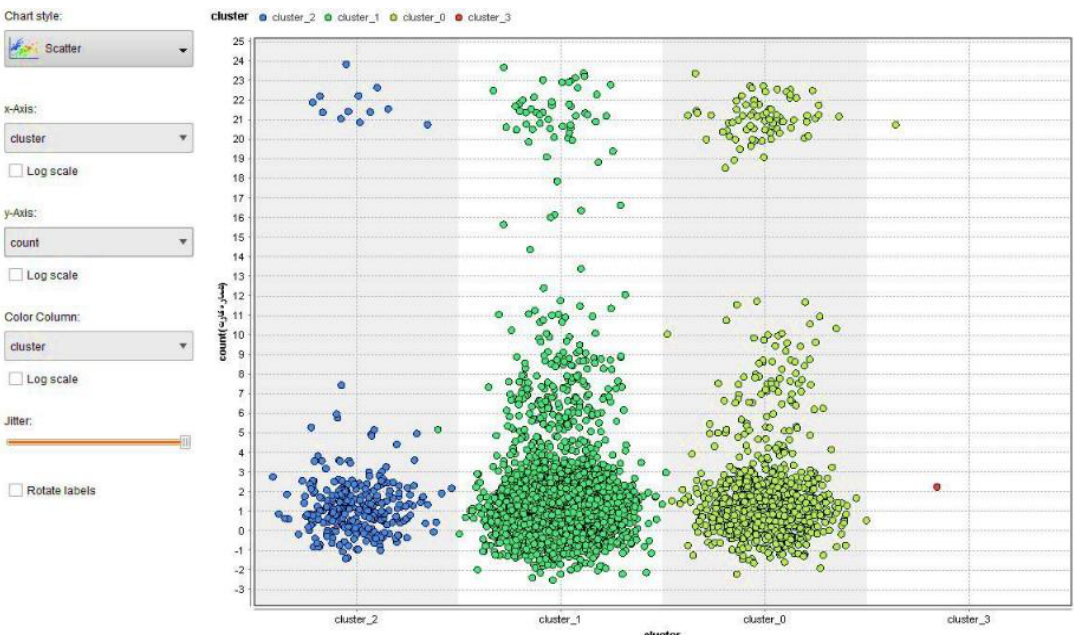
Fig. 3. Data distribution diagram in clusters.